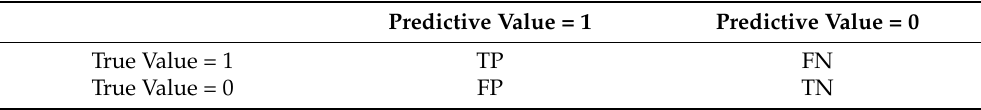
Table 2. Relevant